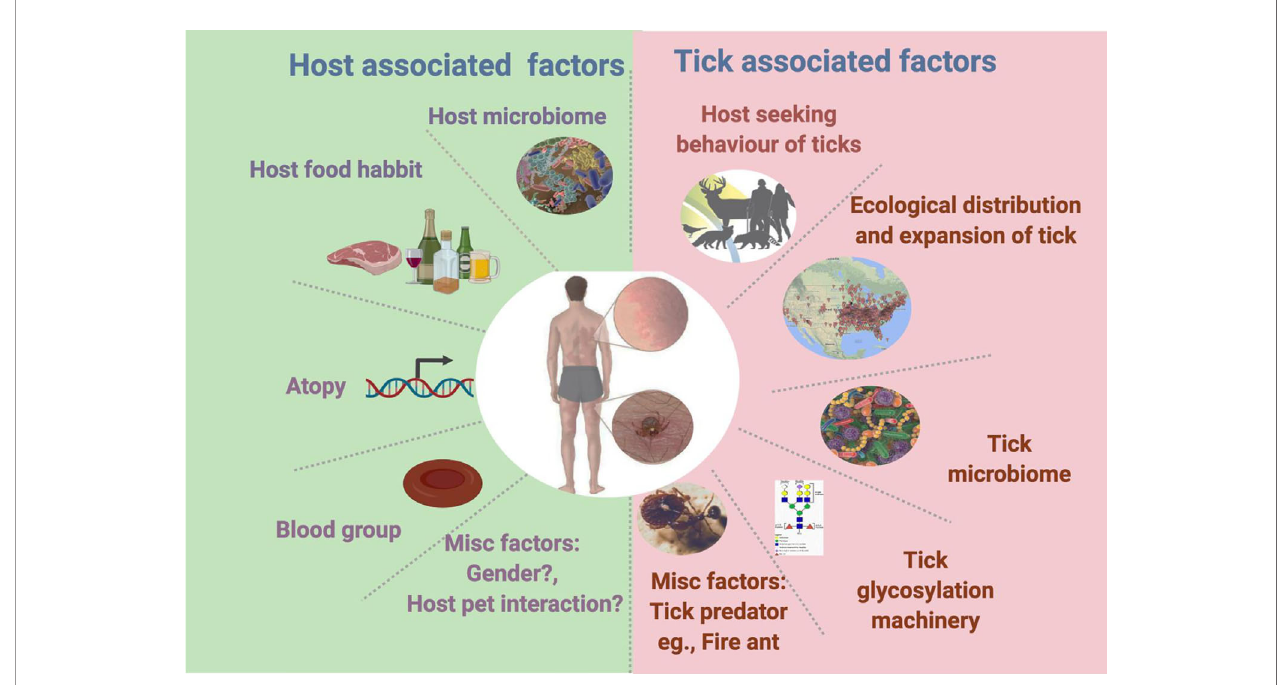
FIGURE 1 | Tick- and host-associated factors linked with alpha-gal